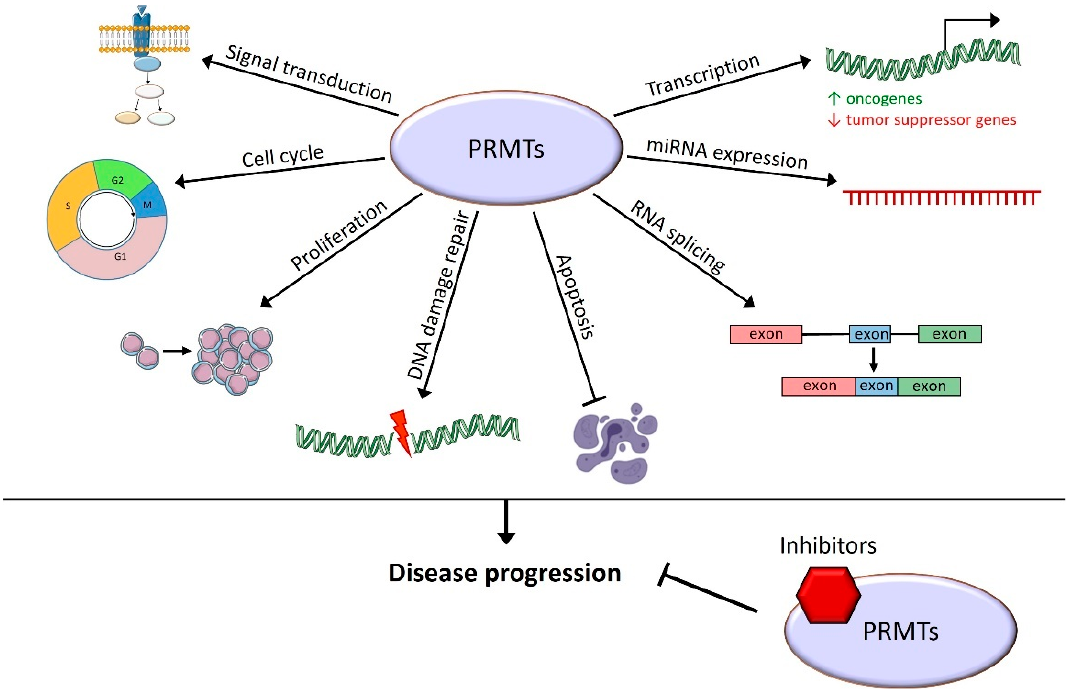
Figure 3. Cellular processes known to be controlled by arginine methylation in hematological malignancies. PRMTs play roles in many cellular functions leading to hematological malignancy progression, and their inhibition has a promising therapeutic effect.